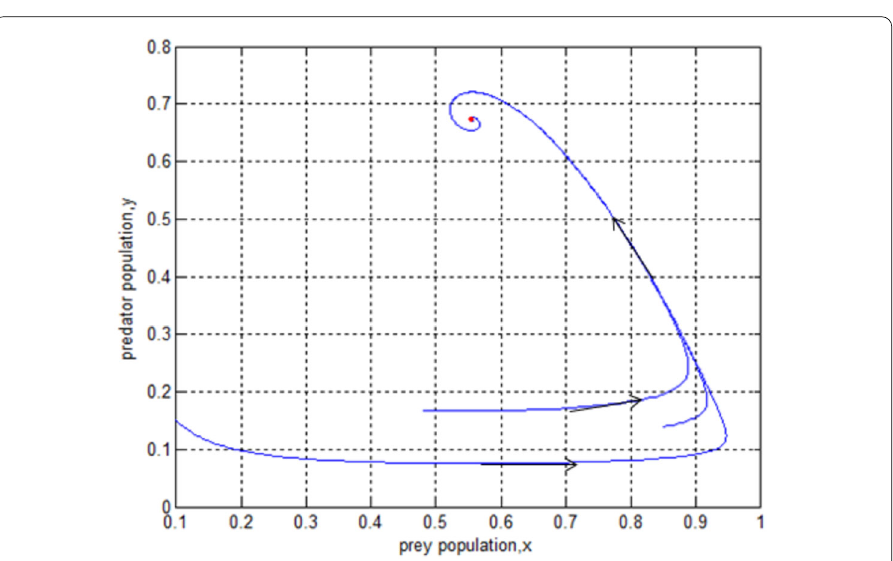
Figure 7 E w 2 = (1,0) is stable